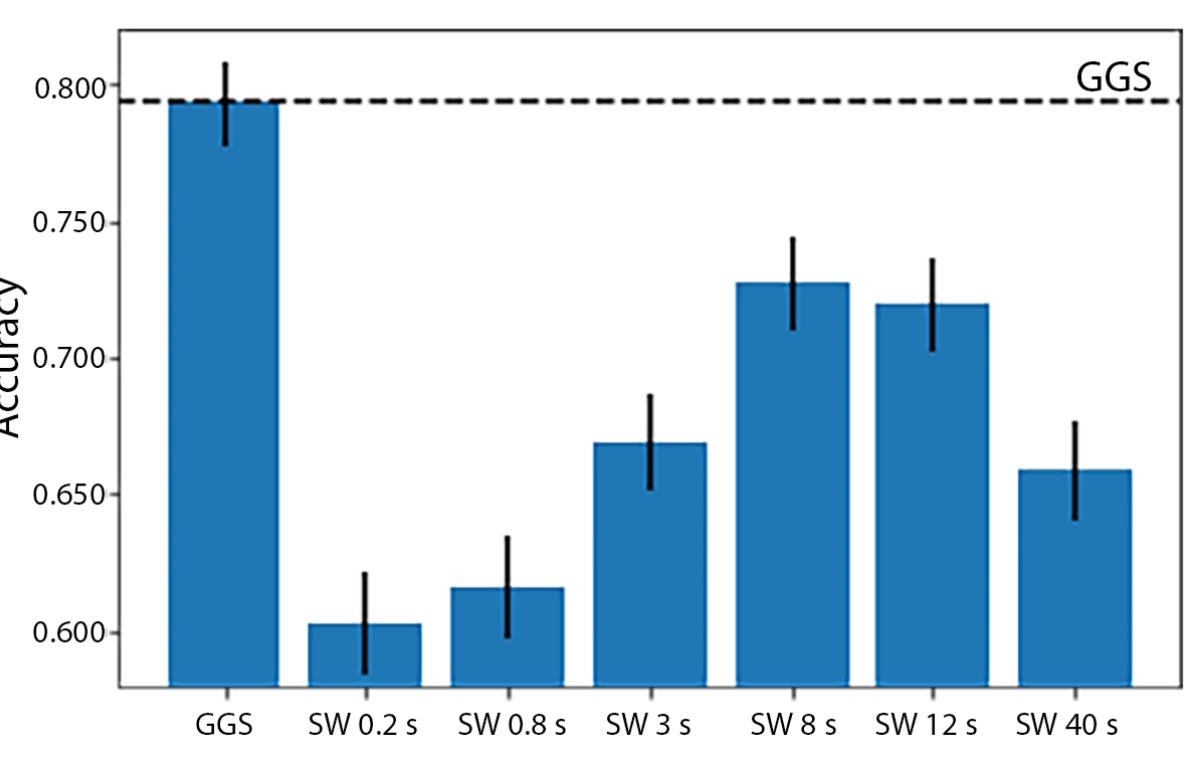
Figure 14. Accuracy of instantaneous predictions from Xgboost using 6 different fixed-size sliding windows (SWs) in the 2 test experiments in the BREATHE dataset. The horizontal dashed line represents the accuracy from Xgboost with greedy Gaussian segmentation. SW: sliding window; GGS: greedy Gaussian